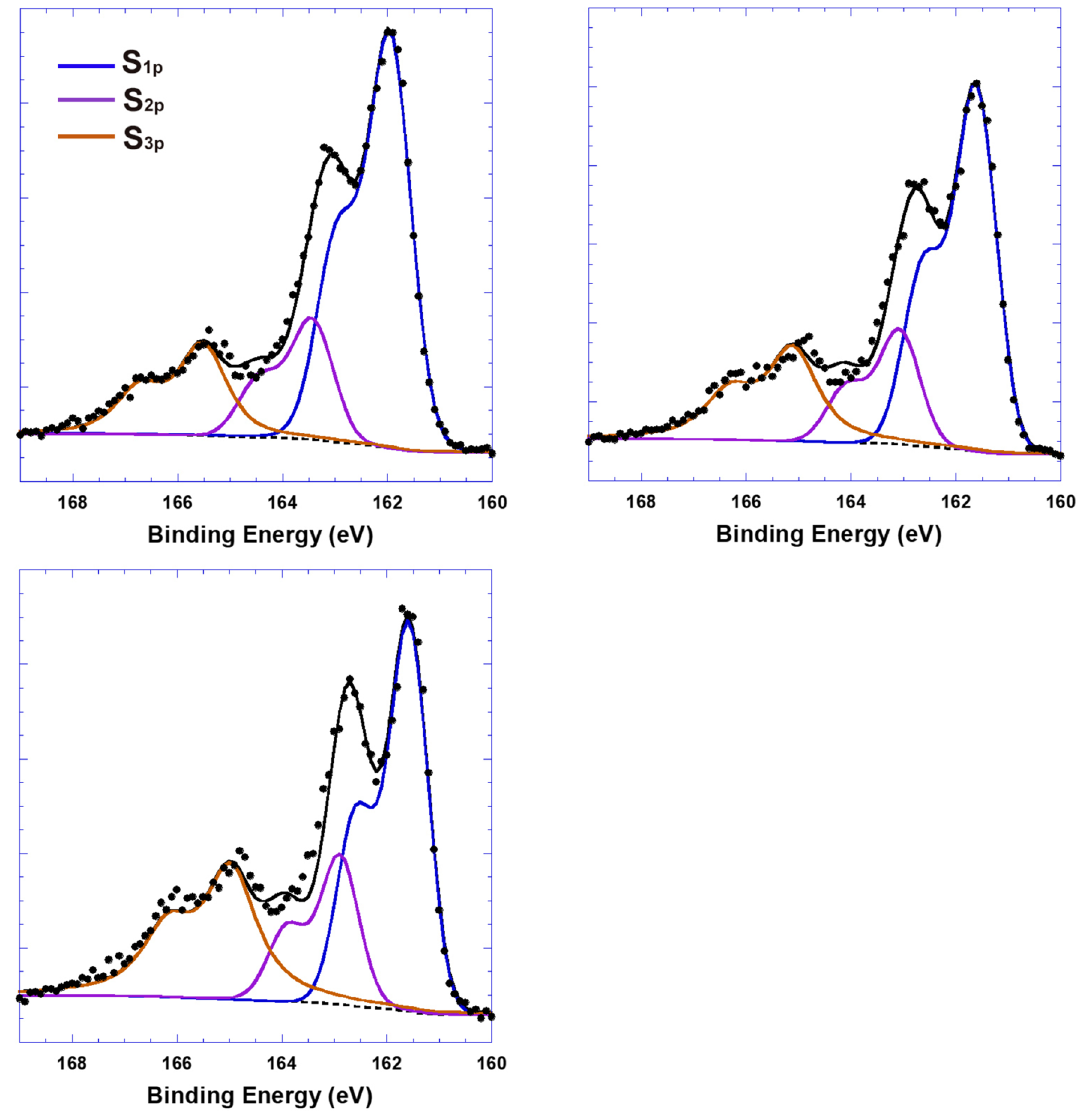
Figure 1. The fitted S 2p XPS spectra of PEDOT:Tos thin films with the doping levels of Tos at ( a ) 23.7%, ( b ) 31.6%, and ( c )